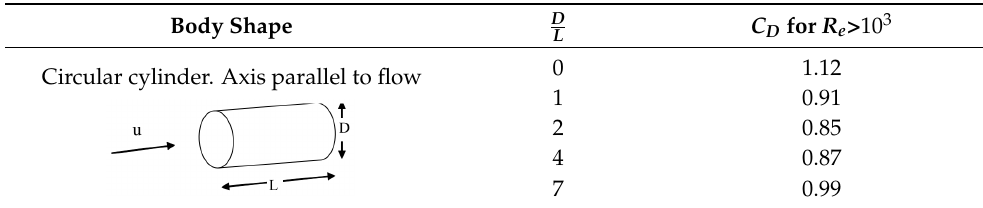
Table A7. Drag coefficients for the flow parallel to the circular cylinder (reproduced from [48], with permission from DNV, 2021).